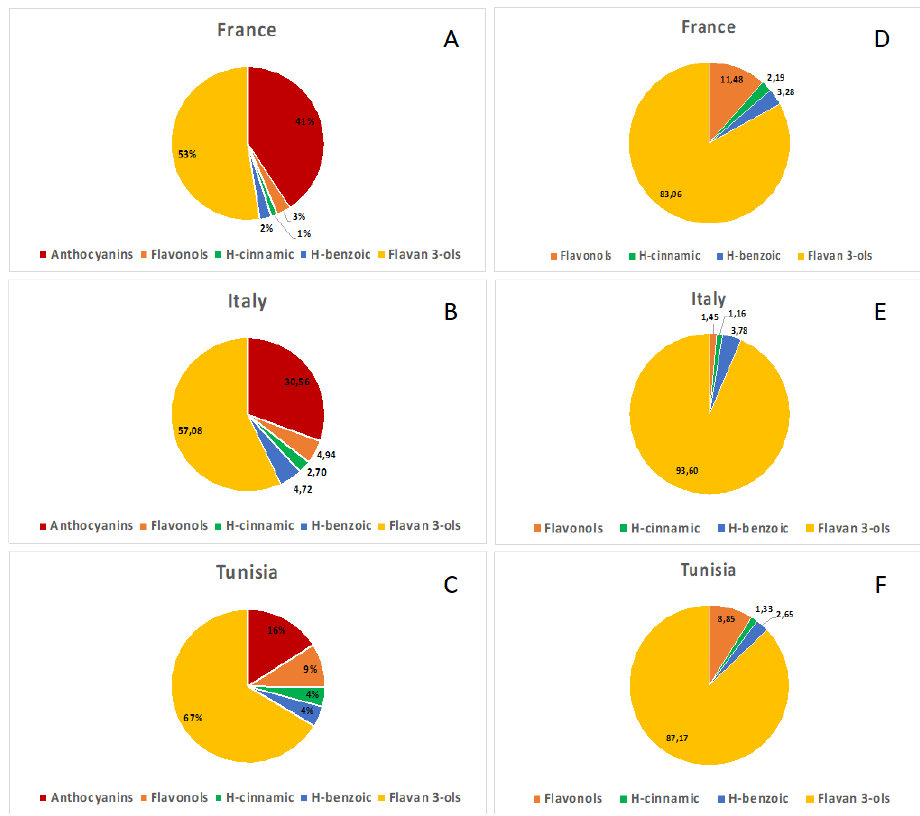
Figure 1. Pie charts of phenolic compounds of analyzed French, Italian, and Tunisian pomace extracts. The different classes of polyphenols are represented as % in figures A , B , and C for Syrah, and in D , E , and F for Chardonnay.